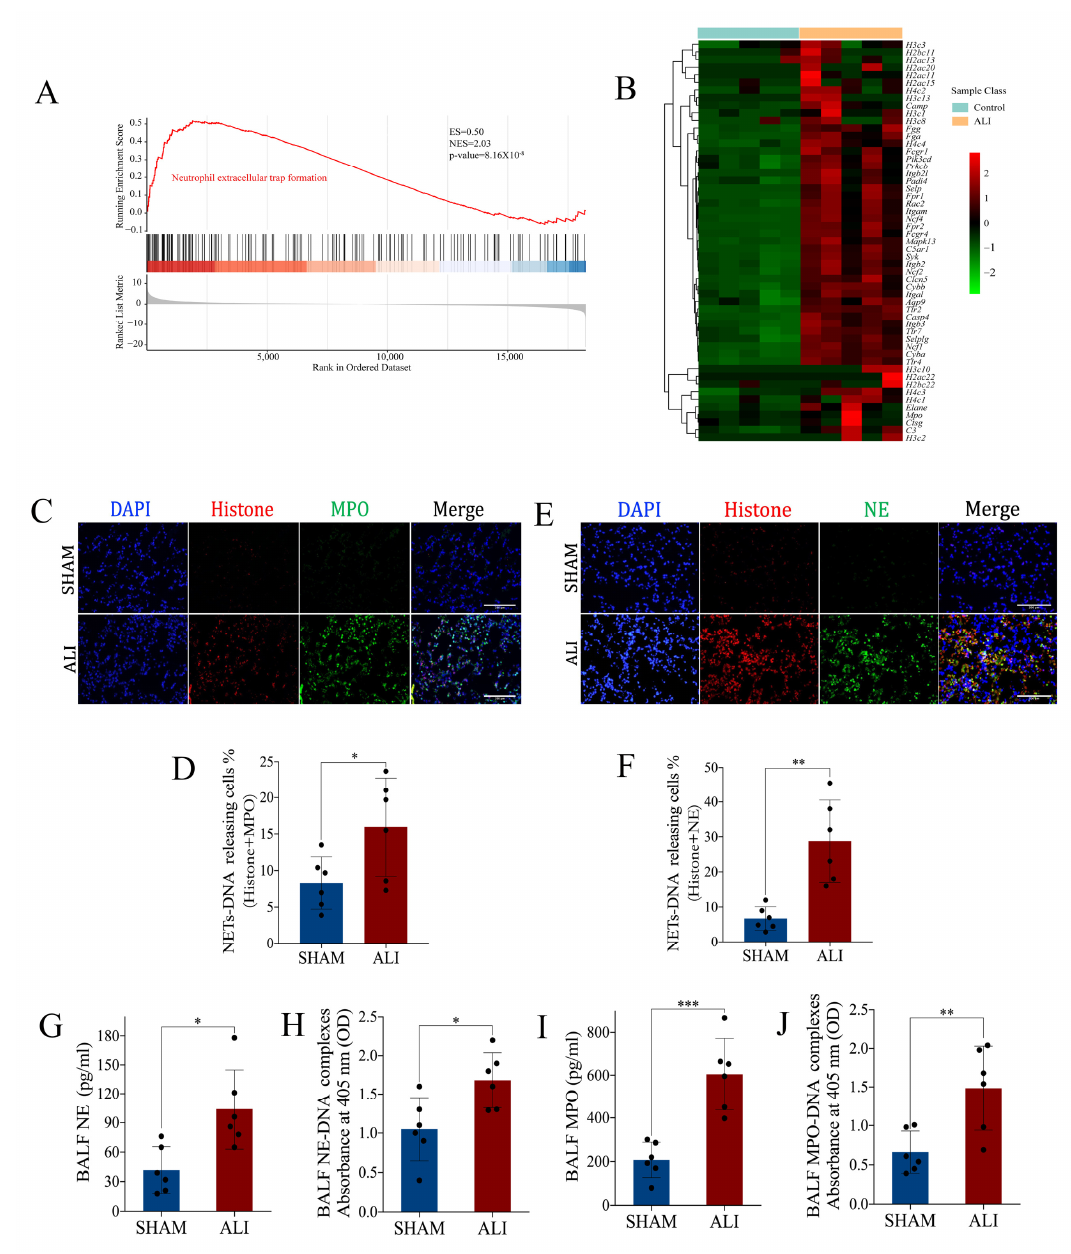
Figure 1. NETs are increased in mice with LPS-induced acute lung injury. Lungs from the ALI model and control were obtained to perform RNA-seq analysis. ( A ) Enrichment plot of the neutrophil extracellular trap formation signaling pathway from GSEA comparing ALI vs. control. ( B ) Heatmap showing the core genes enriched in GSEA in the neutrophil extracellular trap formation signaling pathway. The abscissa indicates the sample number, the ordinate indicates the differentially expressed genes, the right histogram indicates the color scale and each rectangle in the panel corresponds to an expression value in one sample. ( C ) Representative images of immunofluorescence co-localization of histone and MPO (scale bar = 200 µ m). ( D ) The percentage of NET-DNA (histone + MPO)-releasing cells. ( E ) Representative images of immunofluorescence co-localization of histone and NE (scale bar = 200 µ m). ( F ) The percentage of NET-DNA (histone + NE)-releasing cells. ( G ) NE, ( H ) NE- DNA, ( I ) MPO and ( J ) MPO-DNA concentrations in BALF. GSEA = gene set enrichment analysis; ES = enrichment score; NES = normalized enrichment score; ALI = acute lung injury. Data are presented as the mean ± SD, n = 6 per group, * p < 0.05, ** p < 0.01, *** p < 0.001. Comparisons between two groups were analyzed by an unpaired t